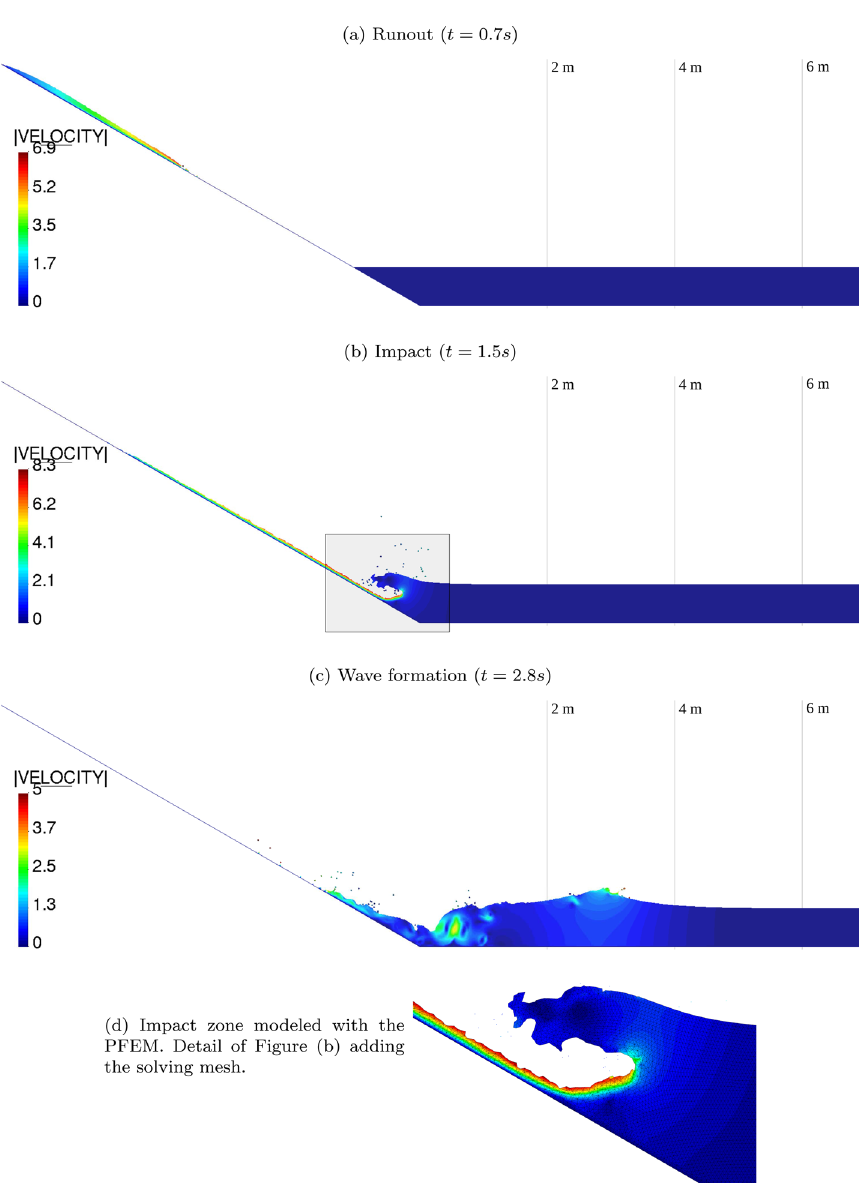
Fig. 10 Landslide wave problem. Near-field results with the PFEM solution of Navier–Stokes problem. The thin vertical lines show the SW interfaces